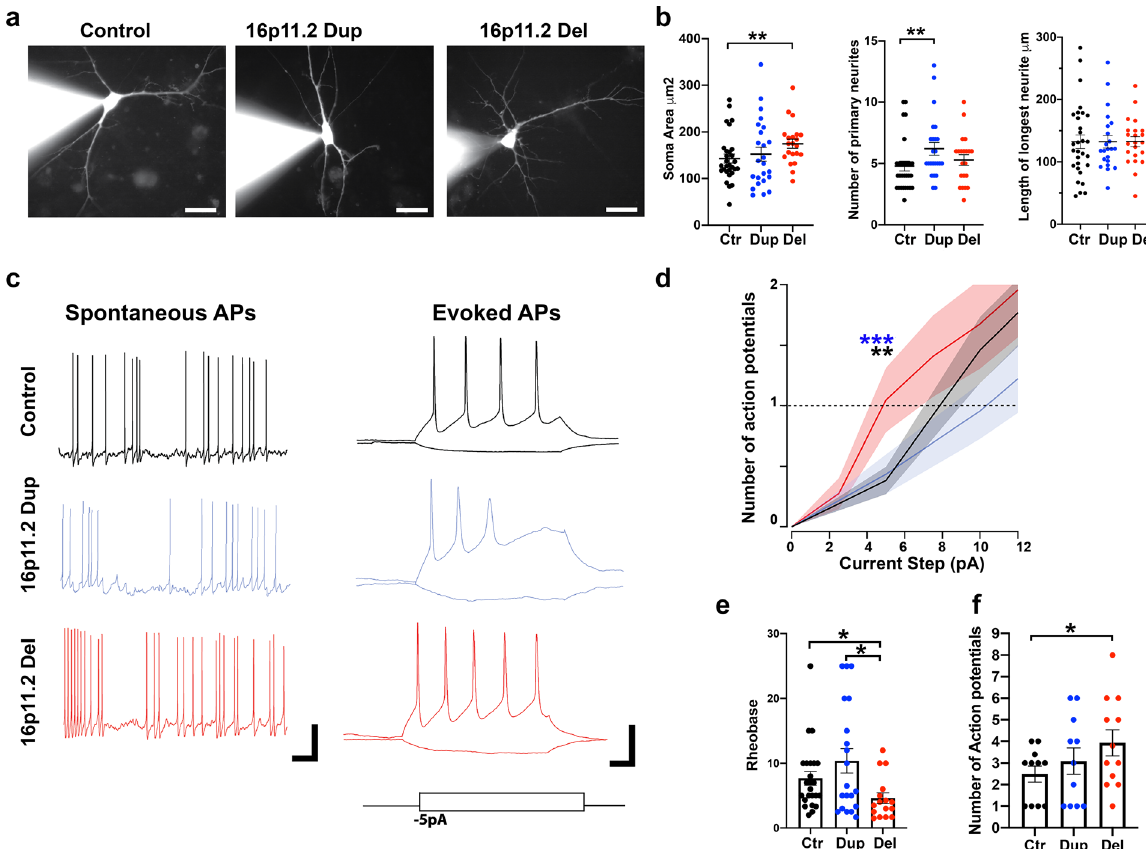
Fig. 4 16p11.2 deletion caused morphological changes and hyperexcitability of the DA neurons. a Representative images of neurons loaded with Alexa Fluor 488 dye (1 µ M) during recordings. Scale bar 25 µ m. The experiment was repeated three independent times with similar results. b Characterization of soma size, number of primary neurites, and length of longest neurite of the patched cells. Soma area was signi fi cantly increased in the 16pdel cells compared to control cells ( p = 0.0076). The number of primary neurites was signi fi cantly higher in the 16pdup cells compared to control cells ( p = 0.0091). There was no statistical difference in the length of longest neurite between the cell groups studied, nonparametric Mann – Whitney test with two- tailed p values, ** p < 0.01. The number of biologically independent samples for soma size and neurite number analyses are n = 29 control, n = 24 16pdup, and n = 21 16pdel. The number of biologically independent samples for neurite length analyses are n = 30 control, n = 22 16pdup, and n = 22 16pdel. Data are presented as mean ± SEM. c Left, representative traces of spontaneous action potentials (APs) at resting membrane ( V m ) ( I hold = 0 pA) in the control, 16pdup, and 16pdel cells. V m of representative current-clamp traces in 16pdel, control, and 16pdup neurons, − 38, − 39, and − 37 mV, respectively. Scale bar 25 mV and 1 s. Right, representative current-clamp recordings demonstrate action potentials in response to current steps of ( + 15 and − 5 pA). Scale bar 10 mV, 50 ms. d Excitability analyses of the DA neurons revealed minimum current input (pA) required to generate the fi rst action potential was signi fi cantly lower in the 16pdel cells compared to control cells. For generating the input – output excitability curve, control, 16pdel, and 16pdup neurons were current clamped to a V m potential of − 60 mV. 16pdel neurons generated signi fi cantly higher number of action potentials compared to control cells or 16pdup cells, ** p < 0.02 and *** p < 0.01. Data are presented as mean ± SEM. e Rheobase values (pA) for control, 16pdup, and 16pdel neurons show signi fi cantly lower Rheobase for 16pdel cells vs. control cells ( p = 0.0126), and 16pdel vs. 16pdup cells ( p = 0.0246), nonparametric Mann – Whitney test with two-tailed p values, * p < 0.05. The number of biologically independent samples are n = 24 control, n = 20 16pdup, and n = 16 16pdel. f Characterization of the number of APs generated by injection of a maximum current stimulation (50 pA) to control, 16pdup and 16pdel neurons. 16pdel neurons generated signi fi cantly higher number of APs compared to control cells ( p = 0.028), parametric unpaired t test with Welch ’ s correction and one-tailed p value, * p < 0.05. The number of biologically independent samples are n = 11 control, n = 11 16pdup, and n = 12 16pdel. Data are presented as mean ± SEM ( e , f ). Source data are provided as a Source Data fi